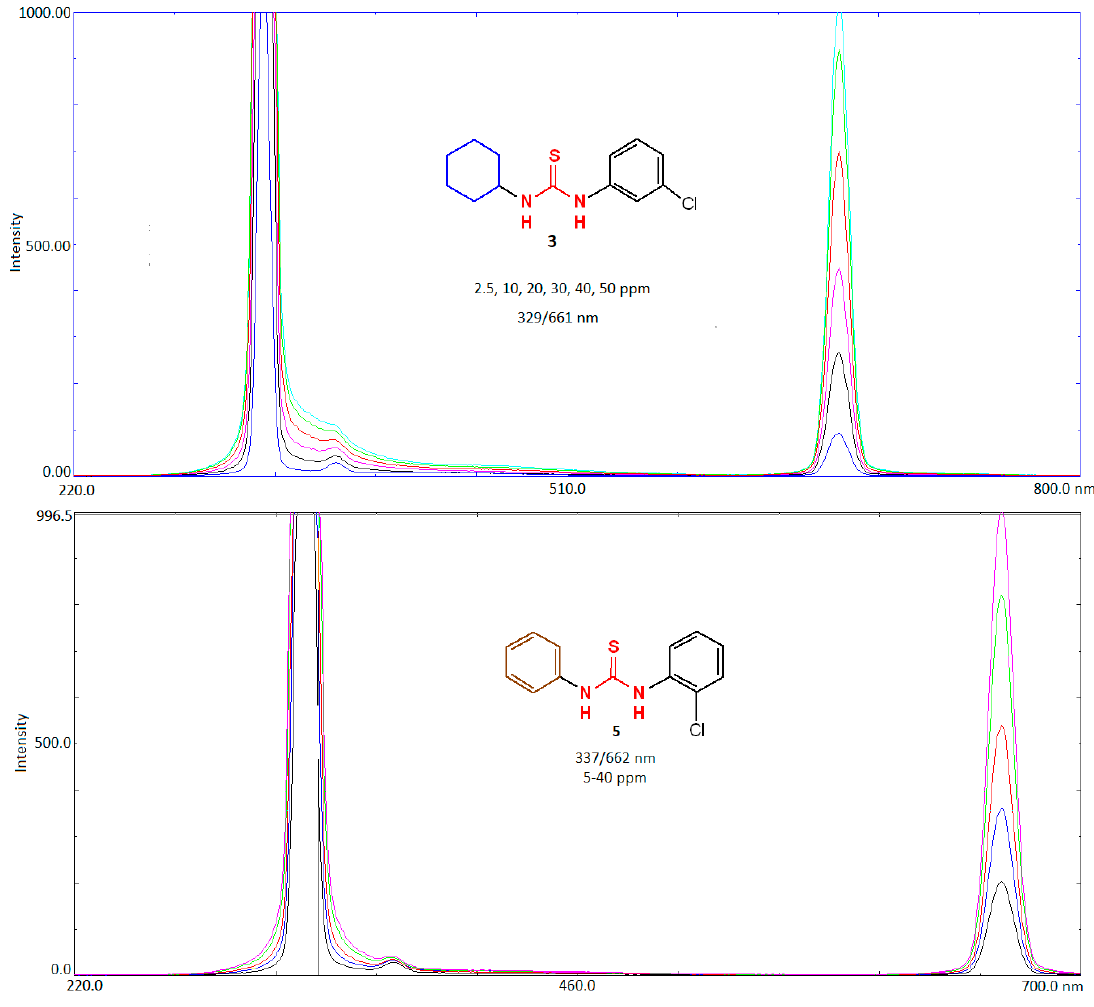
Figure 7. Fluorescence spectra of 3 and 5 as two representative examples. Table 5. Fluorescence characteristics of compounds 1 – 3 , 5 and 6 .